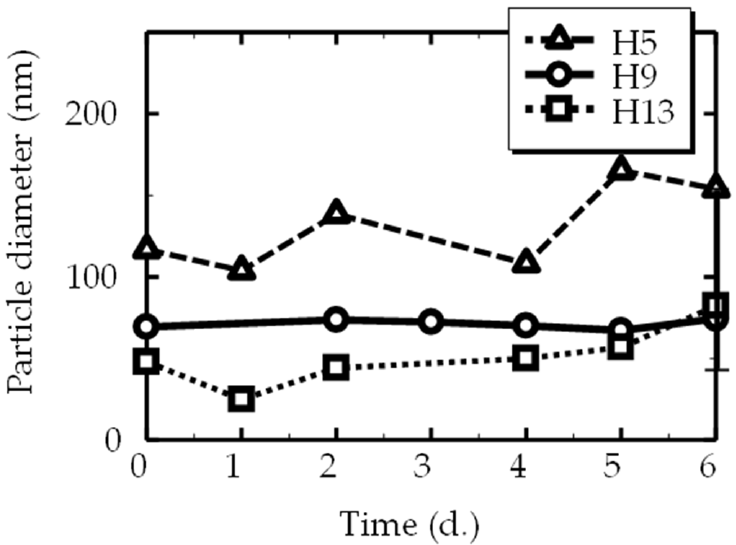
Figure 7. Particle diameter of H5, H9, and H13 nanogels incubated in PBS at 37 °C for 6 days. The biodegradability of H5 nanogels was previously reported [23]. The degradation rates of the H9 and H13 nanogels for protease reactions after 6 days were 91 and 93%, respectively. Additionally, the half-lives of H9 and H13 in PBS were calculated to be 1.5 and 1.7 days, respectively. Proteases cleave covalent bonds in the main peptide chain. Since the crosslinking structure between the peptide side chains was formed by ionizing radiation, the structure of the main chain of the peptide did not change. Therefore, radiation-crosslinked peptide nanogels retain their biodegradability.